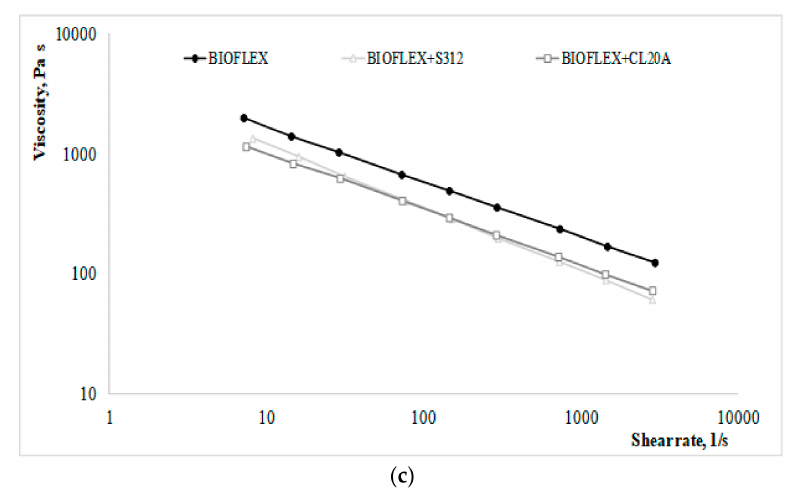
Figure 2. ( a ) Rheological curves of high-density polyethylene (HDPE) without and with a nanofiller; ( b ) rheological curves of MaterBi without and with a nanofiller; ( c ) rheological curves of Bioflex without and with a